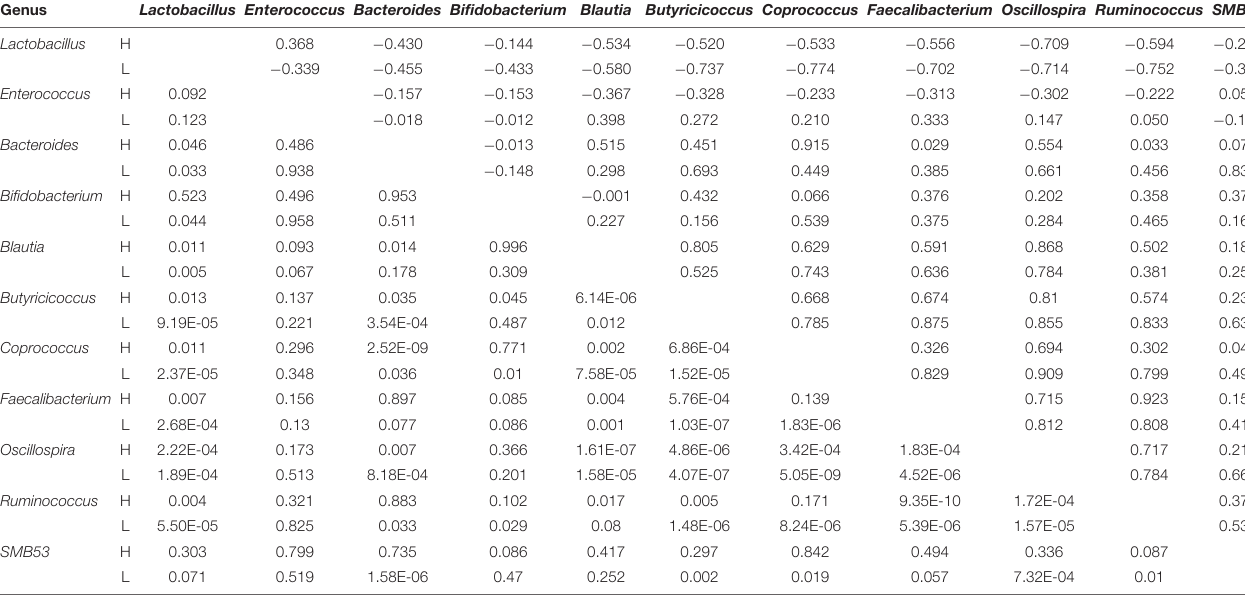
TABLE 2 | Correlation coefficient and significance of part of the microbes at genus level in the duodenum of HFE and LFE groups.